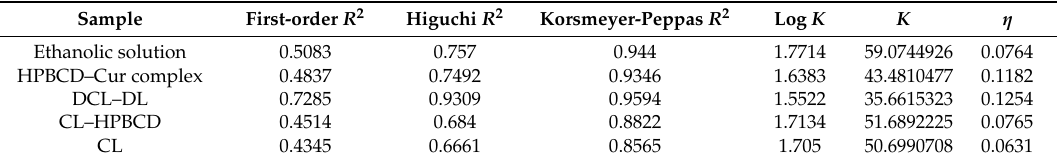
Table 8. R 2 values of the first-order kinetic, Higuchi models, and Korsmeyer-Peppas models. Kinetic parameters for the Korsmeyer-Peppas model: K represents the release rate constant; η represents the release mechanism of